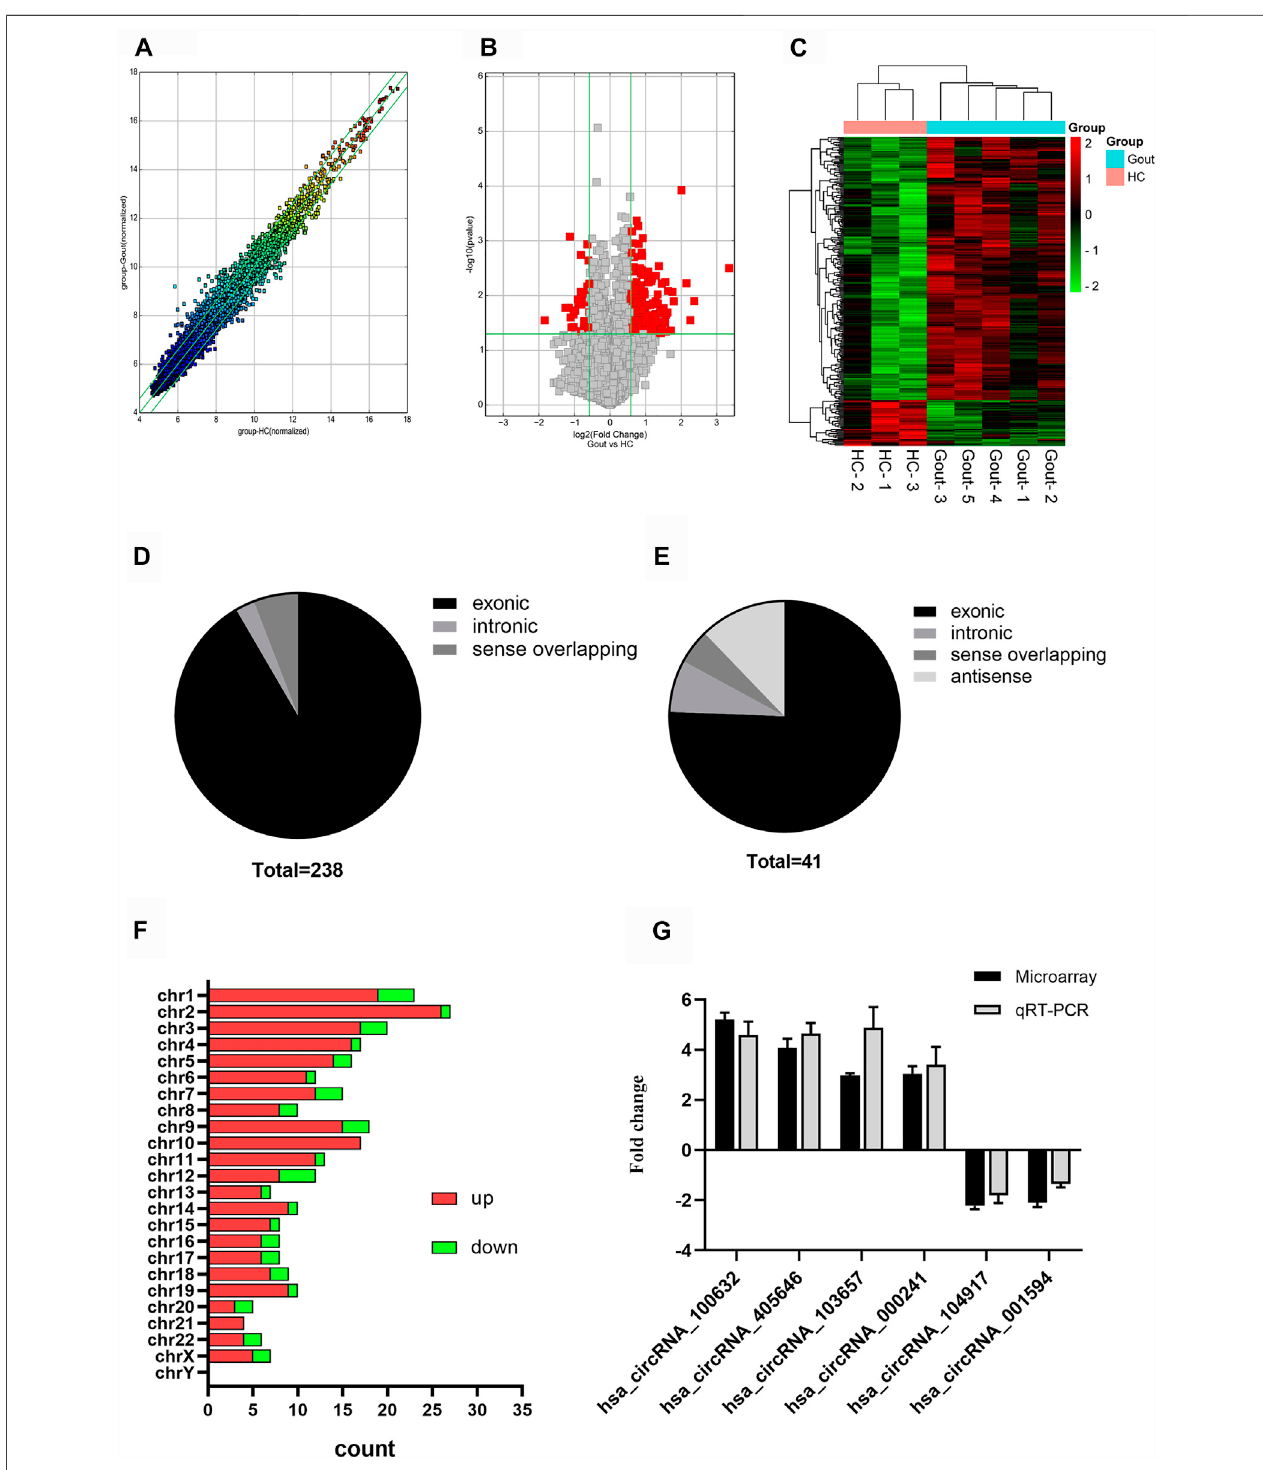
FIGURE1 | Expression pro fi les ofcircRNAs in gout patients compared with healthy controls. (A) Scatter plot demonstratingthe heterogeneityof theexpression of circRNAs in the gout and HC groups. The values of the X and Y axes represent the averaged normalized signal values of the groups (log2-scaled). The green line represents 1.5-fold changes. The expression of circRNAs above the top green line and below the bottom green line indicates changes by > 2-fold between the two groups. (B) Volcano plots visualizing differentially expressed circRNAs between the two groups. The vertical lines correspond to 1.5-fold up- and downregulated circRNA expression. The horizontal line represents a p -value of 0.05. The red point in the plot represents signi fi cantly differentially expressed circRNAs. (C) Clustered